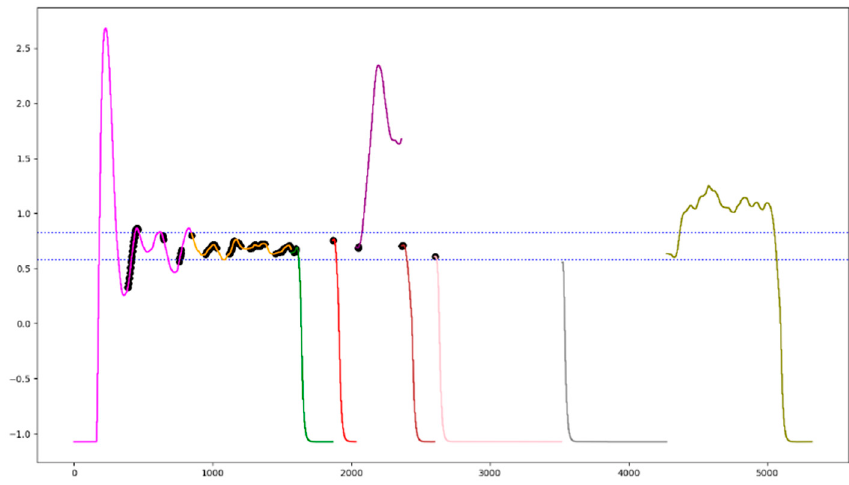
Figure 14. Airflow sensor readings and samples in the box [6,10]. The color legend can be consulted in Table 4.